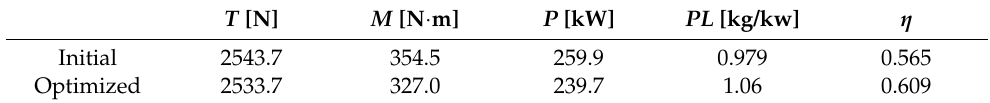
Table 5. Performance comparison between the optimized blade and the initial blade.